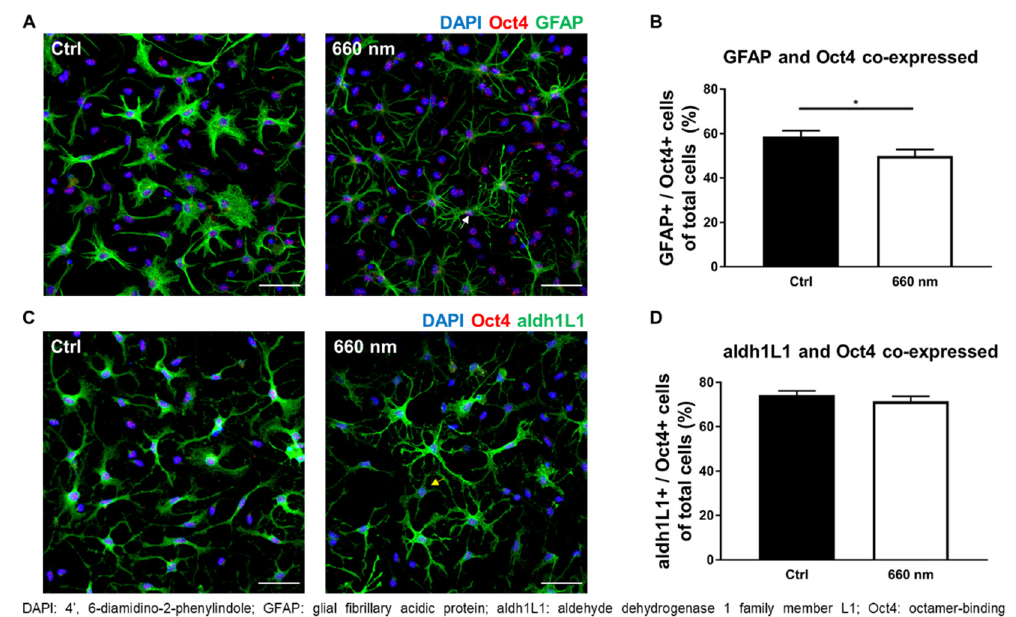
Figure 5. Astrocytic Differentiation Could be altered by 660-nanometer LED Irradiation (Oct4 co-expression). ( A and C ) Representative images of immunofluorescence staining (scale bar: 50 μ m). ( A ) The white arrow denotes GFAP- and Oct4 co-expressing cells, which were significantly decreased by 660-nanometer LED irradiation. ( C ) The yellow arrow denotes aldh1L1- and Oct4 co-expressing cells. ( B and D ) The graph of protein expression was shown. Compared to the control, 660-nanometer LED irradiation significantly decreased GFAP+/Oct4+ cell expression ( n = 35, * p < 0.05) and aldh1L1+/Oct4 showed only a decreased tendency.